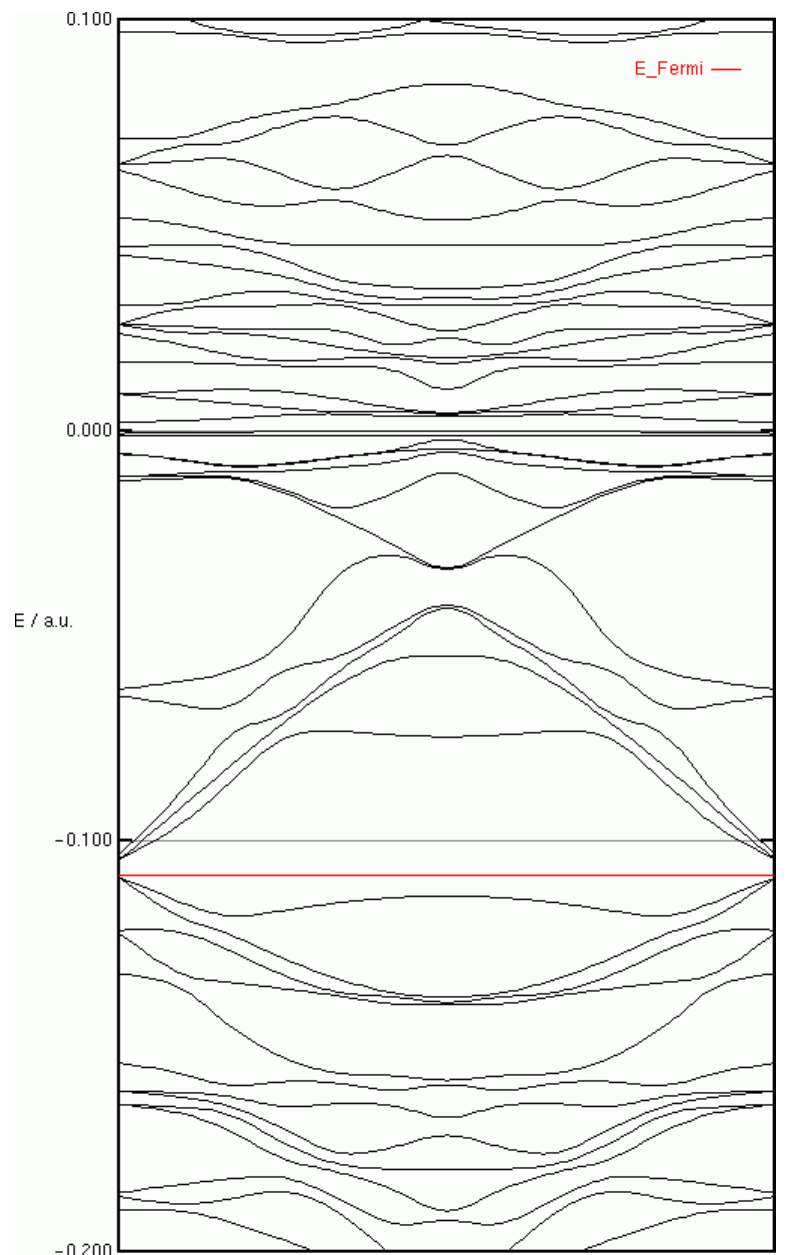
along c* direction near the Fermi level. There are 940 bands Figure 9 The band structure of the Cr ∞ involved. The red line in the figure is the Fermi level, which is at –0.108 e/au. The band gap between HOMO and LUMO bands is 0.0044